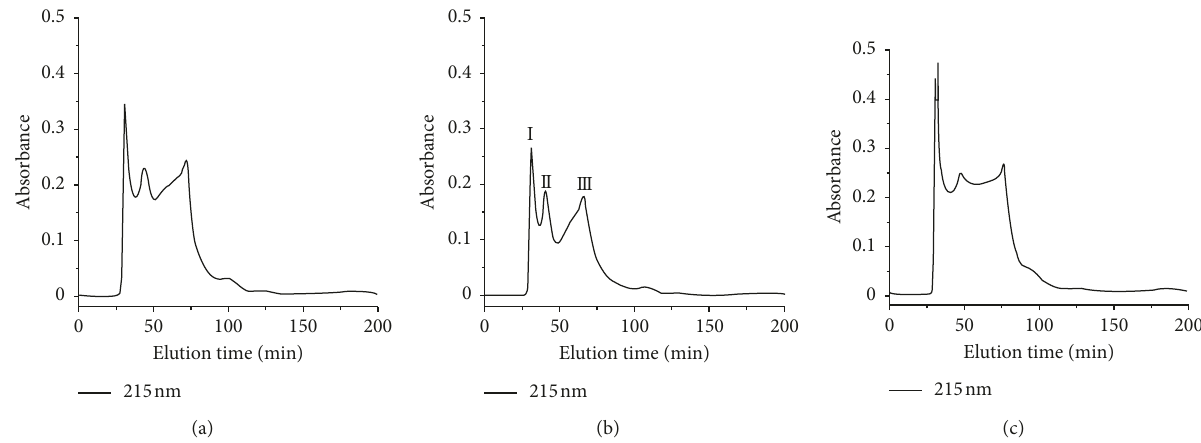
Figure 4: Separation of Sephadex G-15 at sample concentrations of 10mg/mL (a), 25mg/mL (b), and 50mg/mL (c).